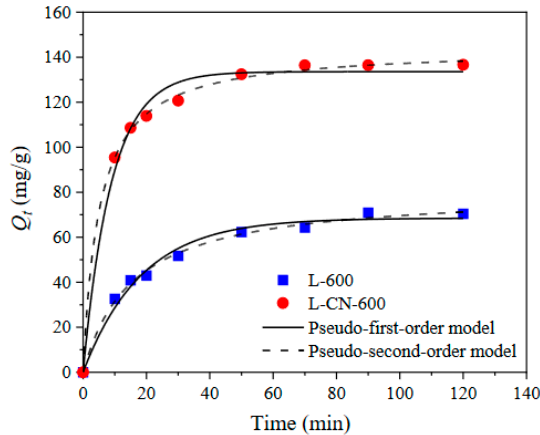
Figure 9. Adsorption kinetic curves of lignite-based porous carbons. Adsorption conditions: C 0 = 133 mg/L, m / v = 0.4 g/L, 20 °C.